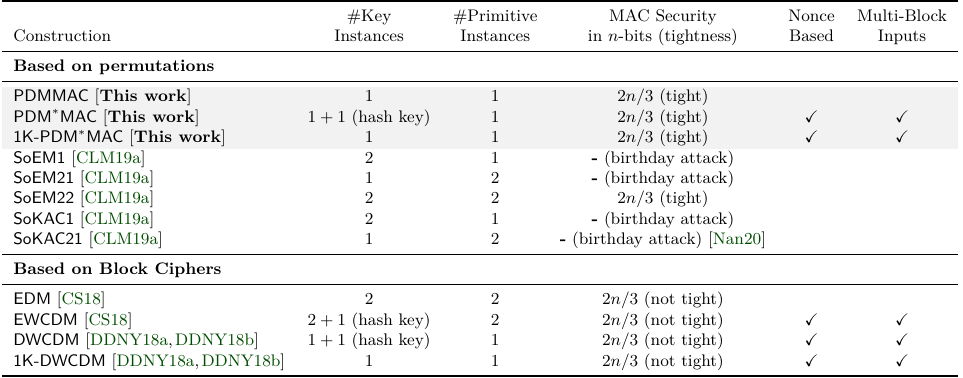
Table 1: Comparison of existing PRFs. #Keys and #Primitives denote number of key and primitive